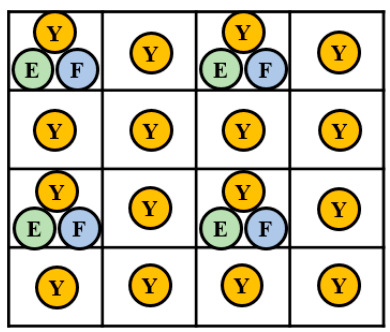
Figure 4. Four types of 4:2:0 sampling